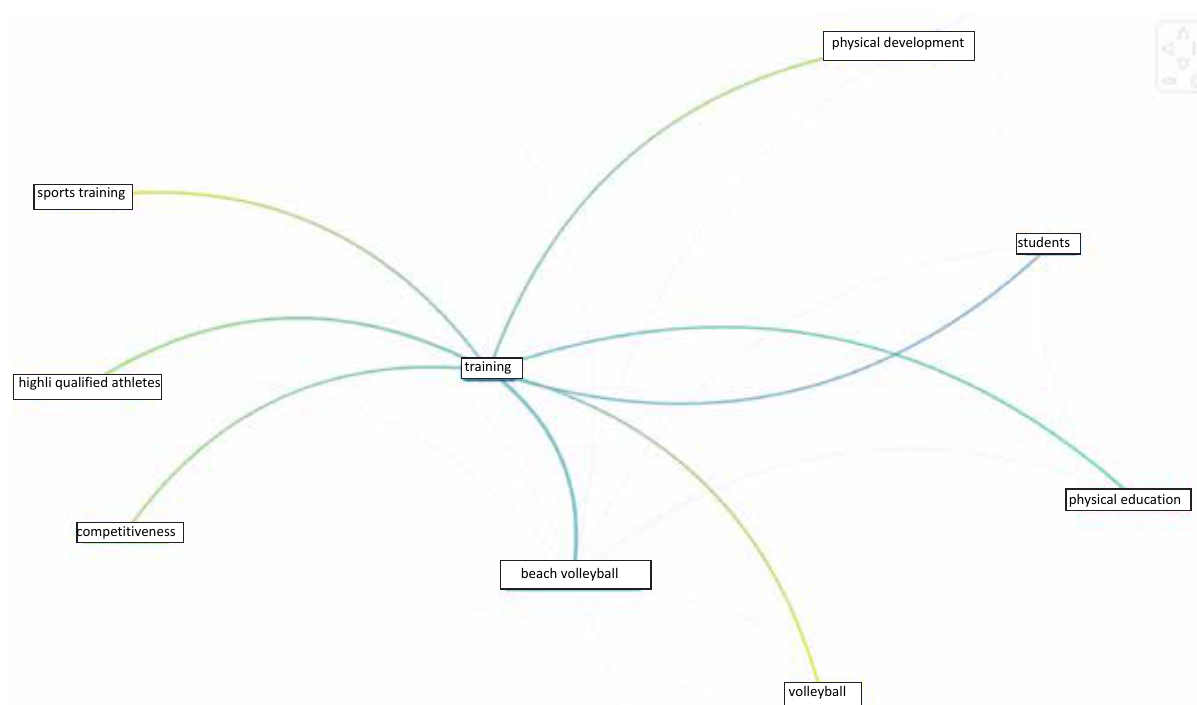
Figure 7. Data visualization by keyword “training” (source: own research based on data extracted from SEL database and analyzed with VOSviewer;